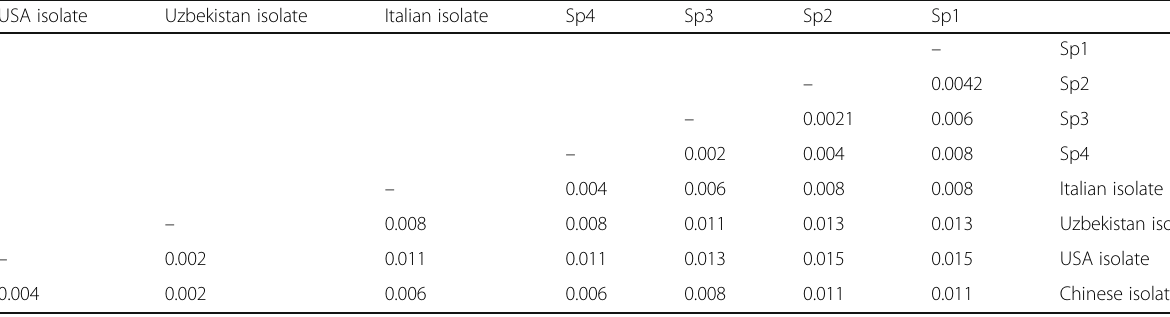
Table 2 Pairwise genetic distances among the different isolates studied USA